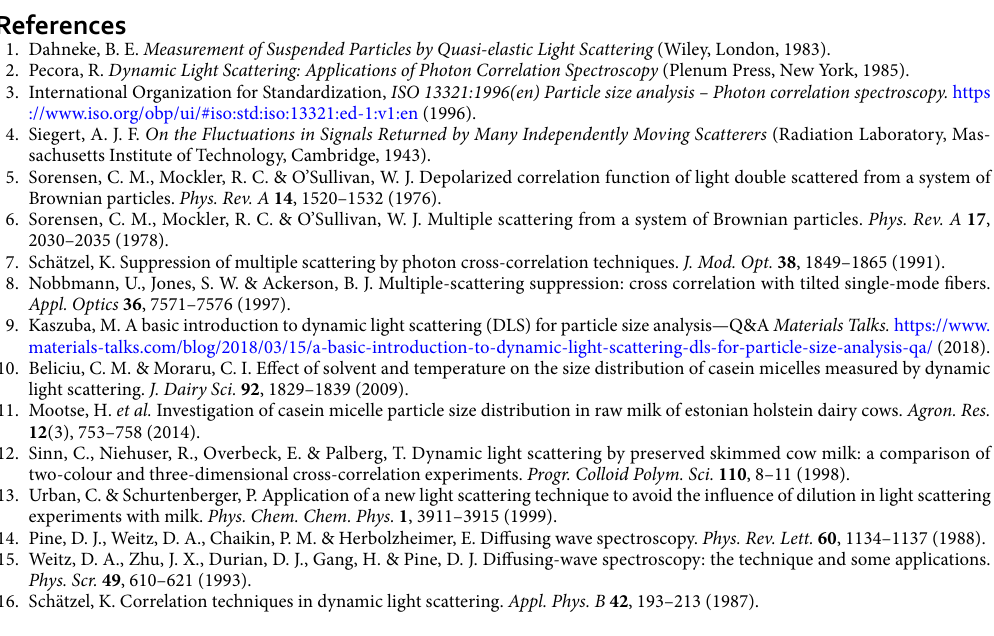
in average size between undiluted and diluted milk based on measurement position. Looking at contributions from both VV and VH detection versus no polarizer detection may help to ascertain the presence or absence of multiple scattering, and thus avoid incorrect interpretation of dynamic light scattering results.